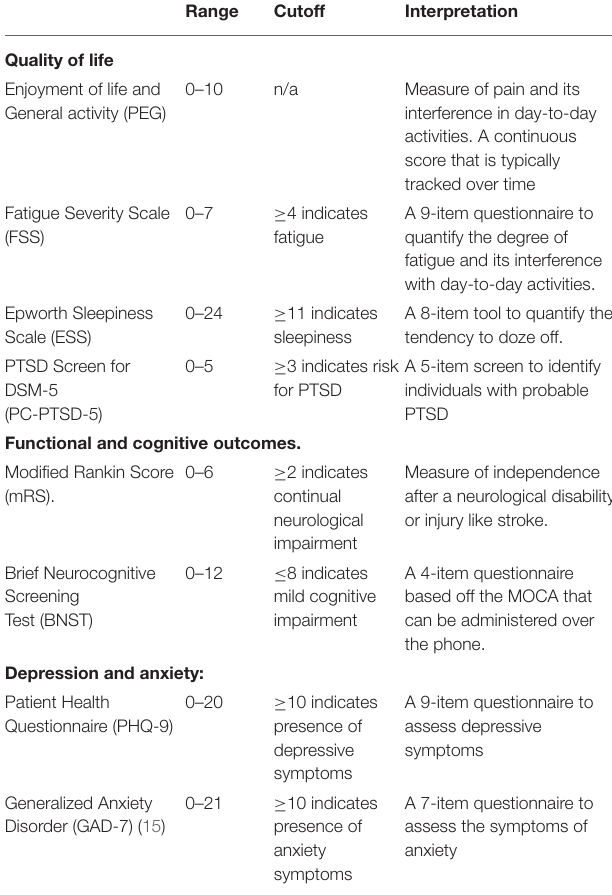
TABLE 1 | Battery of